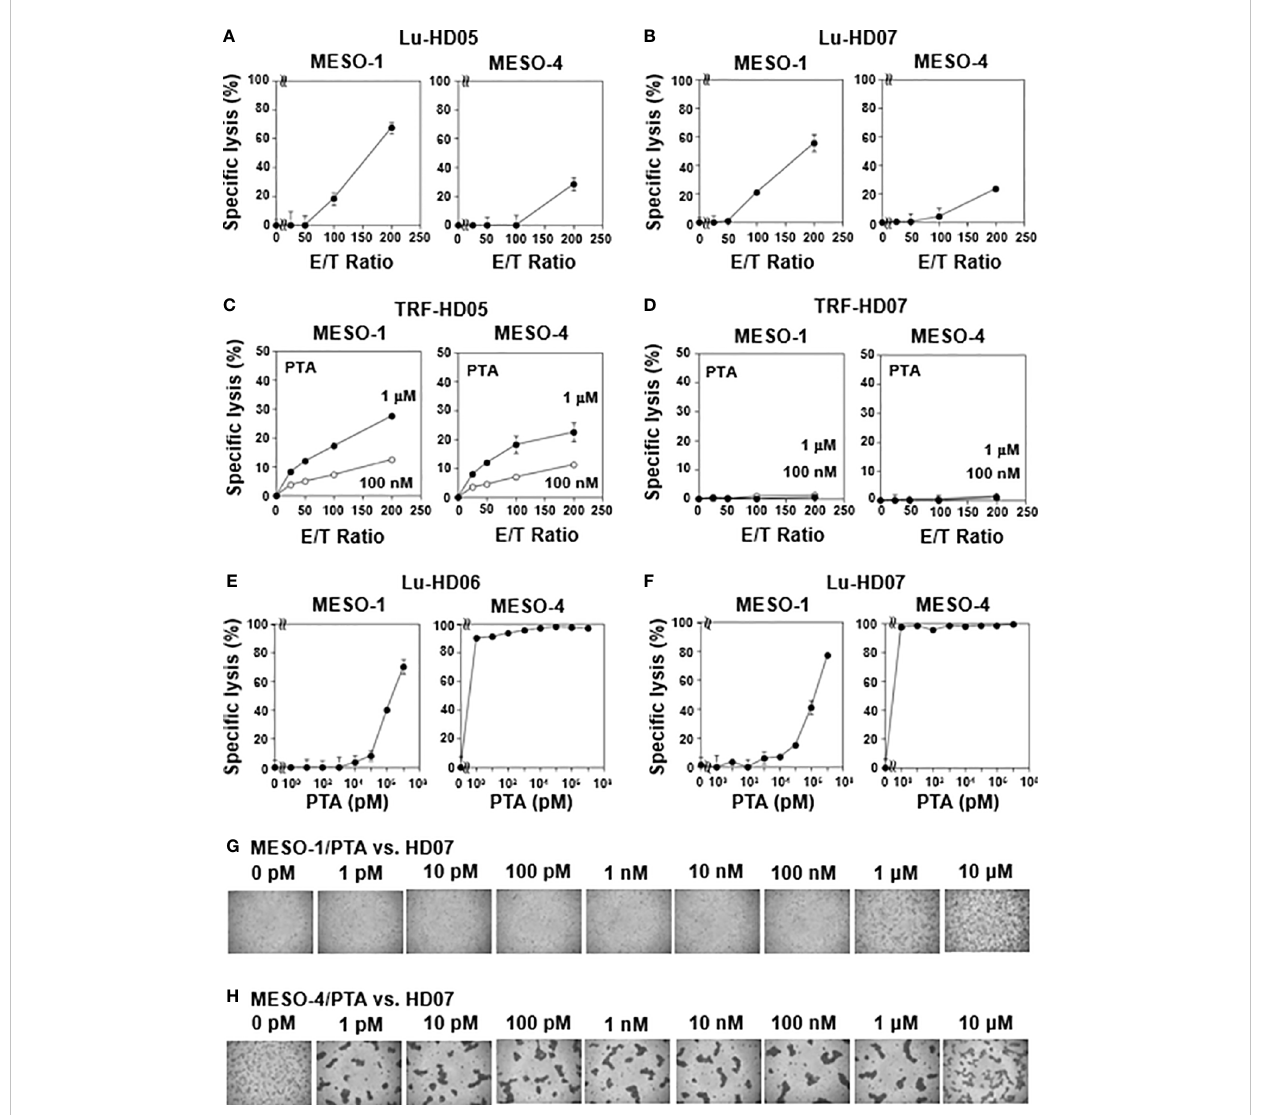
FIGURE 1 Natural killer-like activity and antigen-driven cytotoxicity against MPM cells exhibited by human gd T cells. (A, B) Effect of effector-to-target ratios on cytotoxic activity of gd T cells derived from healthy donors. MESO-1 and MESO-4 cells (2 x 10 4 cells) were treated with a serial dilution of gd T cells derived from healthy donors HD05 (A) or HD07 (B) at 37 °C for 72 h and speci fi c lysis (%) was determined based on luciferase assay. (C, D) Effect of PTA on cytotoxicity elicited by gd T cells derived from healthy donors. MPM cells (5 x 10 3 cells) pulsed with PTA (100 nM or 1 m M) were challenged by gd T cells derived from HD05 (C) or HD07 (D) at 37 °C for 1 h and speci fi c lysis (%) was determined by Eu assay. (E, F) Effect of PTA on cytotoxic activity of gd T cells derived from healthy donors. MPM cells (2 x 10 4 cells) were incubated with gd T cells derived from HD06 (E) or HD07 (F) in the presence of a serial dilution of PTA at 37 °C for 48 h and speci fi c lysis (%) was determined by luciferase assay. (G, H) Microscopic analysis of MPM cells challenged by gd T cells in the presence of PTA. Cell mixtures in (F) were observed under a microscope for MESO-1 (G) and MESO-4 (H)